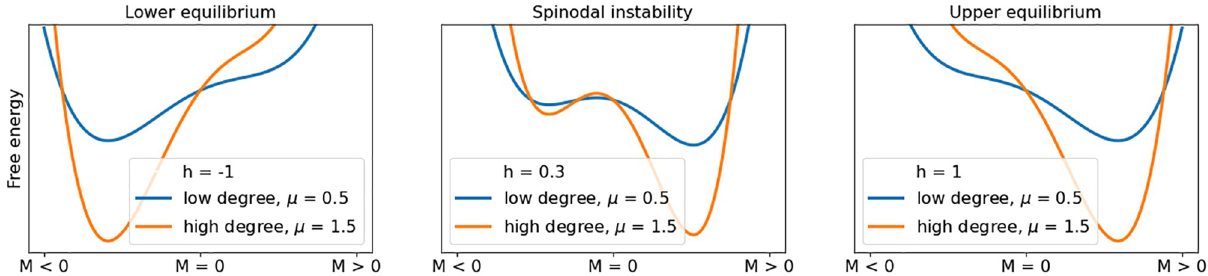
Fig 8. Critical transitions in the Ising model in Ginzburg-Landau form driven by an external magnetic field h with different neighborhood sizes considered by parameter μ expressing different depths of the attractor basins.